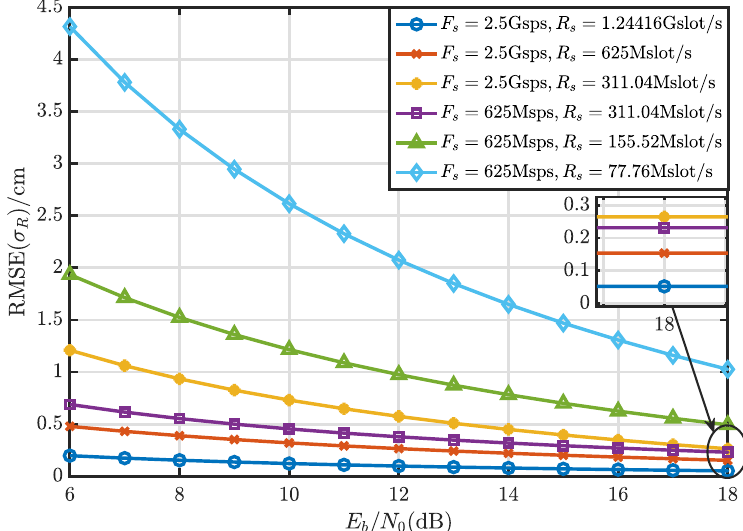
Figure 6. Ranging accuracy ( σ R ) simulation